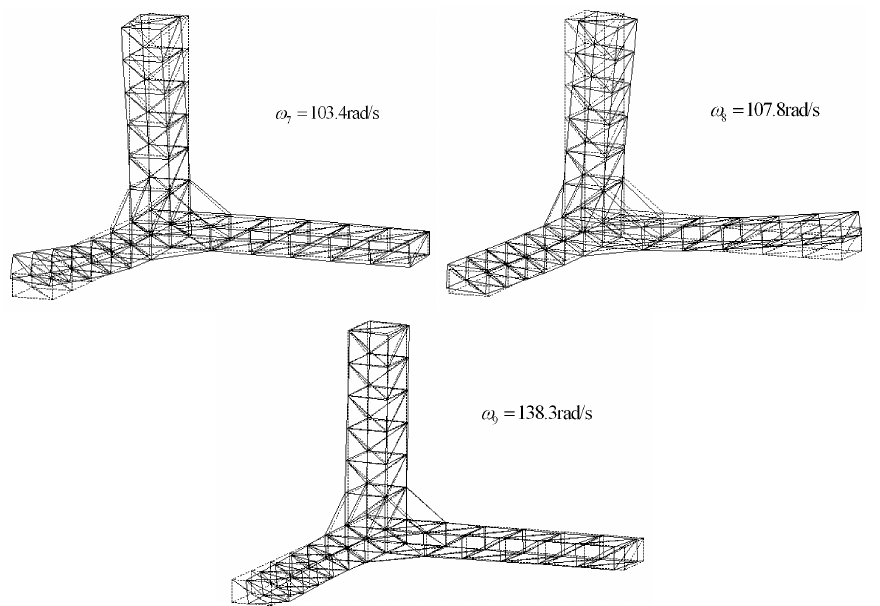
Figure 2. Mode shapes of the